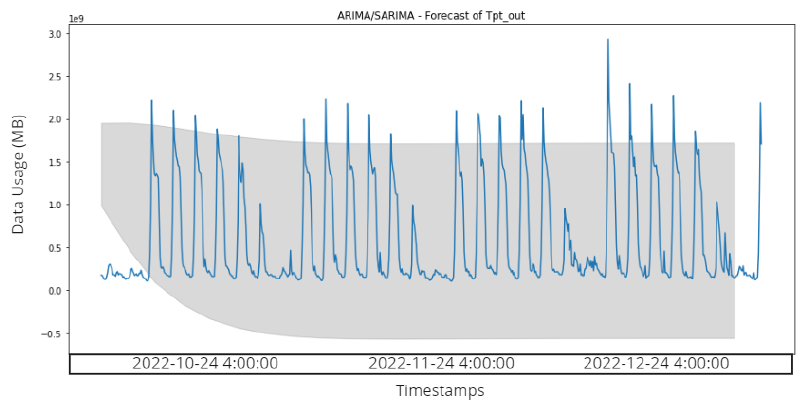
Figure 20. The ARIMA